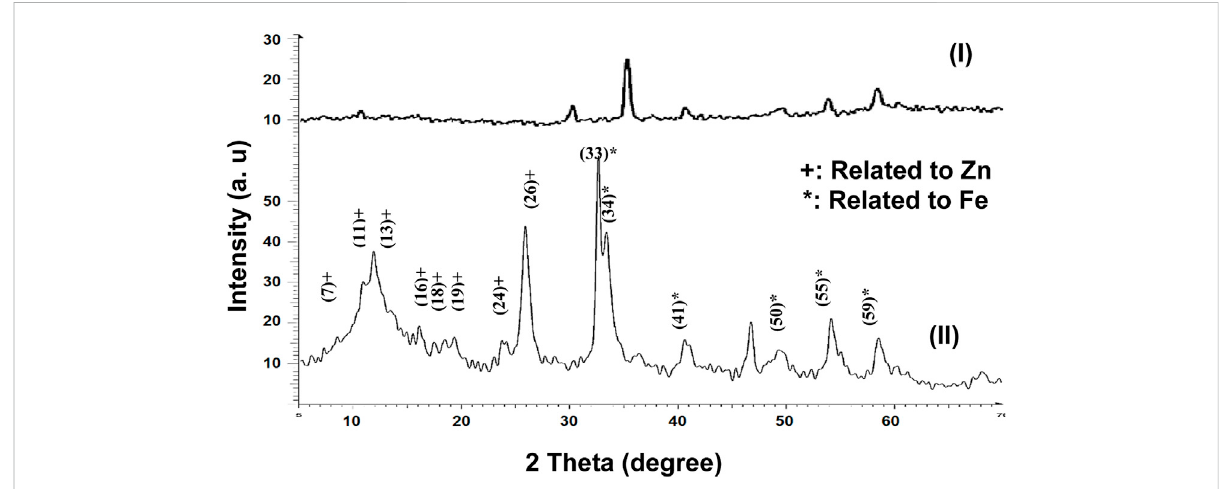
FIGURE 1 XRD patterns of Fe 3 O 4 (I) Fe 3 O 4 /Zn-metal organic framework magnetic nanostructures (II).